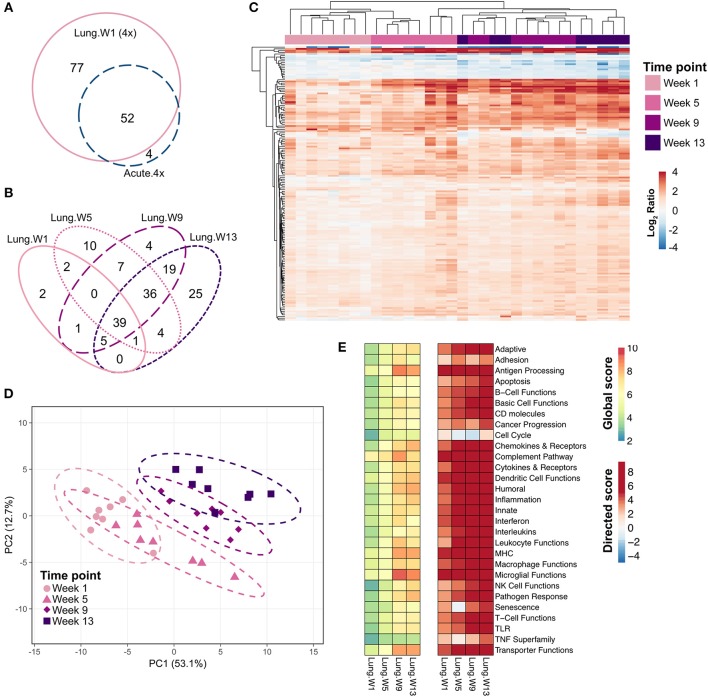
Chronic transcriptional response of immune-associated genes in lung tissues of mice 1, 5, 9, or 13 weeks post cSiO2 instillation. Mice received four repeated weekly doses of cSiO2 or saline vehicle (VEH) via intranasal instillation, and gene expression was determined in lung tissues obtained 1, 5, 9, or 13 weeks post instillation. (A) Venn diagram depicting the number of genes identified as differentially expressed in lung tissue of mice 1 day (Acute.4x) or 1 week (Lung.W1) post cSiO2 instillation compared to dosing-matched vehicle controls. (B) Venn diagram depicting the number of genes identified as differentially expressed in lung tissues over time as compared to time-matched, vehicle-exposed mice. (C) Principal components analysis of differentially expressed genes (BH q < 0.05, log2 ratio >1 or < −1) in lung tissues of mice exposed to cSiO2 at 1, 5, 9, or 13 weeks post instillation compared to time-matched vehicle controls. PC1 and PC2 are shown with 95% confidence interval bands (dashed ellipses). (D) Unsupervised, bidirectional hierarchical cluster analysis of lung transcriptome data at weeks 1, 5, 9, or 13 using the Euclidean distance method with average linkage. All genes differentially expressed at any of the time points were included in the heatmap, which is colored by the log2 ratio calculated with respect to average expression in time-matched vehicle controls. (E) Heatmaps depicting either global or directed significance scores for immune-related pathways (see Materials and Methods for details on calculation of significance scores).